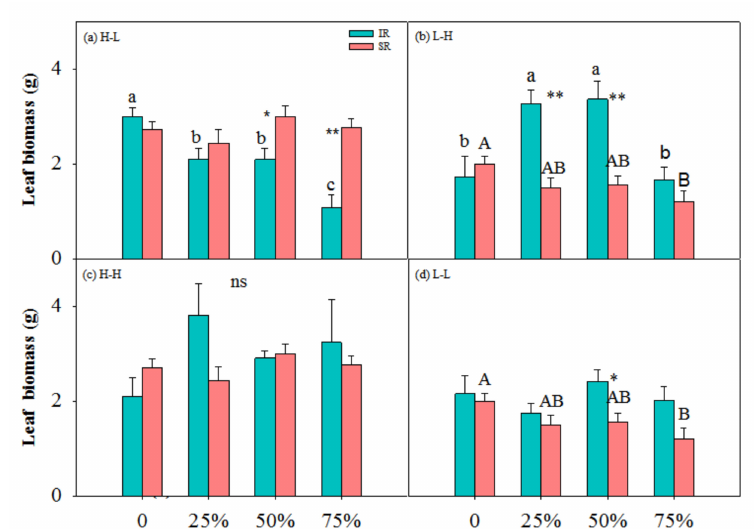
Figure 2. Leaf biomass of ramets with intact rhizome (IR) and severed rhizome (SR) with increasing clipping levels in di ff erent nutrient treatments. ( a ) H-L, ( b ) L-H, ( c ) H-H and ( d ) L-L indicate high-low, low-high, high-high and low-low nutrient treatments, respectively. The error bars represent standard errors (SE), and bars with di ff erent lower-case and upper-case letters indicate significant di ff erence among clipping levels for ramets with intact and severed rhizome, respectively ( p < 0.05). *—significant di ff erence between ramets with IR vs. SR at the same clipping